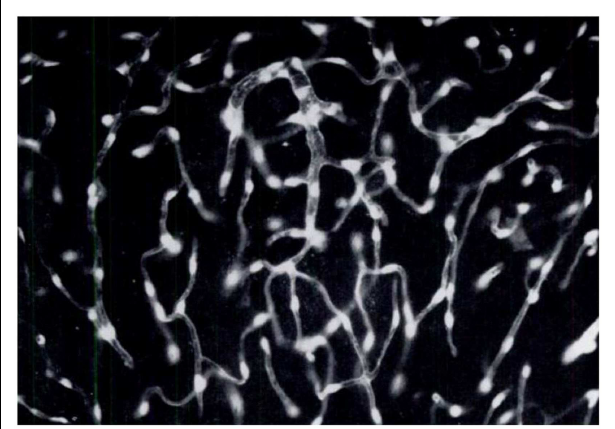
FIGURE 5 | Brain endothelial cells and pericytes produce dopamine following systemic administration of L -DOPA . In the 60s, a group of Swedish pharmacologists led by E. Rosengren discovered that brain endothelial cells and pericytes are a significant site of dopamine production following treatment with L -DOPA.This photomicrograph represents a section of rat cerebellum processed for the Falck–Hillarp catecholamine histofluorescence method to visualize DA-containing cells.The rat had received an injection of L -DOPA (50mg/kg, combined with the monoamine-B inhibitor nialamide) shortly before being killed.The authors commented, “It was evident that the fluorescent material occurred throughout the capillary walls giving almost a three-dimensional appearance of the capillary tubes. Fluorescence of high intensity (was found) in cytoplasm and nucleus of both endothelial cells and pericytes” [Reproduced with permission from Ref.